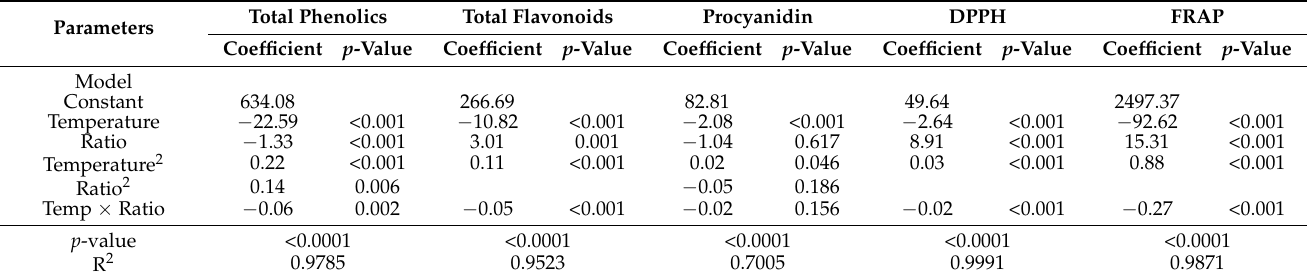
Table 2. Parameters of regression model for actual factors.